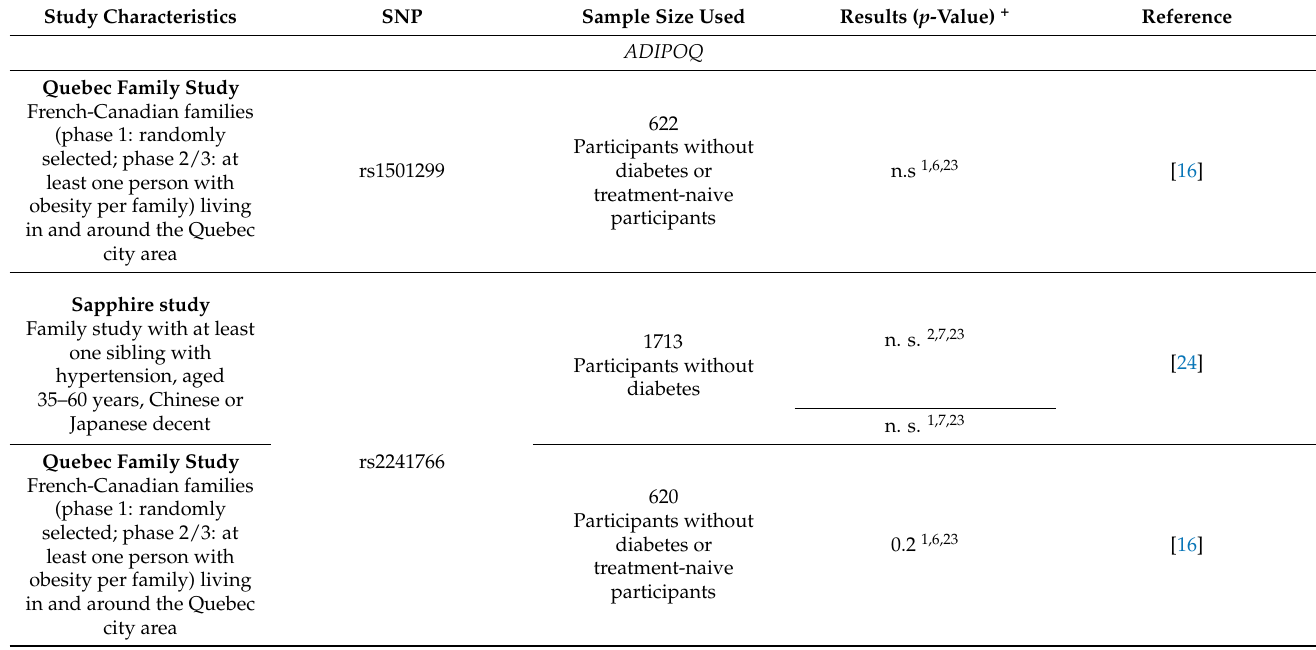
Table 4. Associations between SNPs and gAUC after an OGTT in adults. Gene loci are examined in at least three different